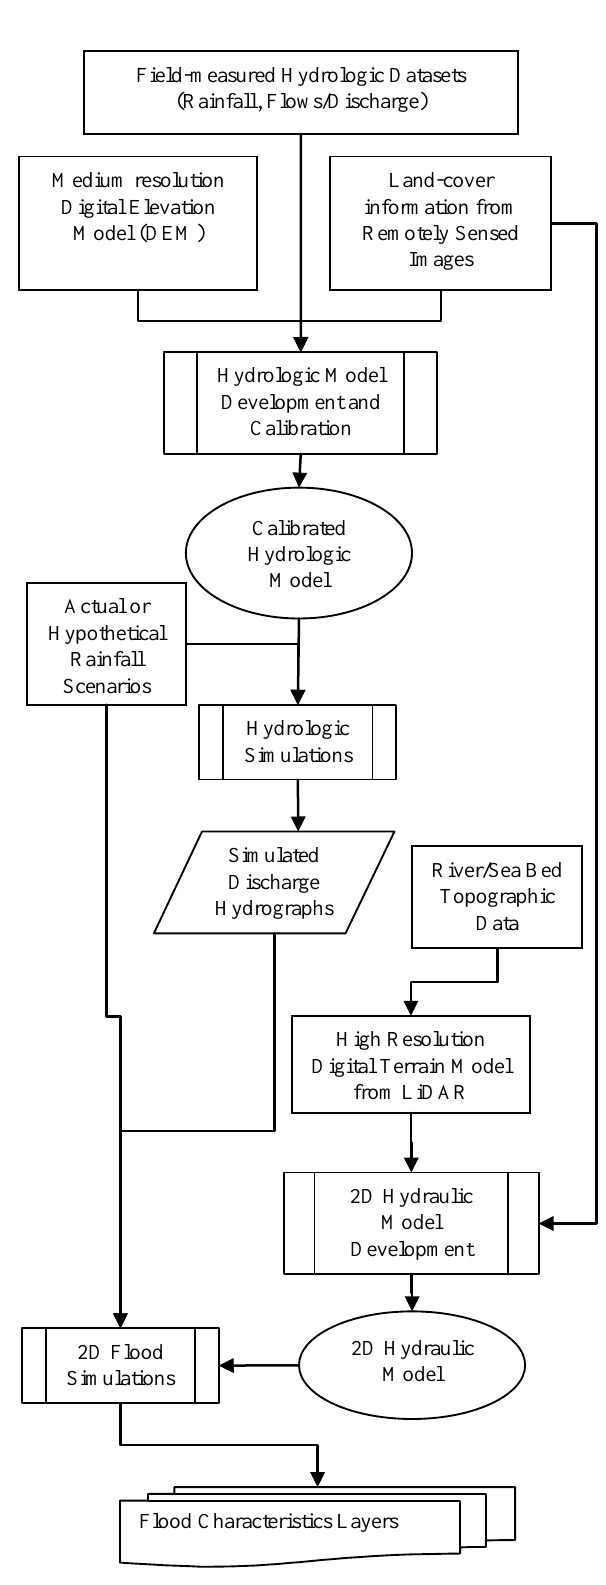
Figure 1. An illustration of the approach to generate detailed flood